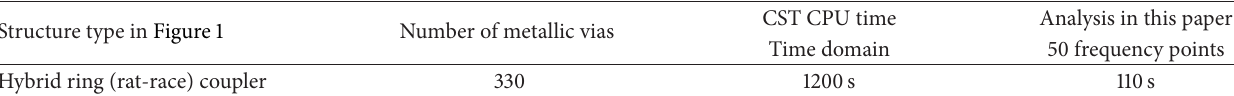
Structure type in Figure